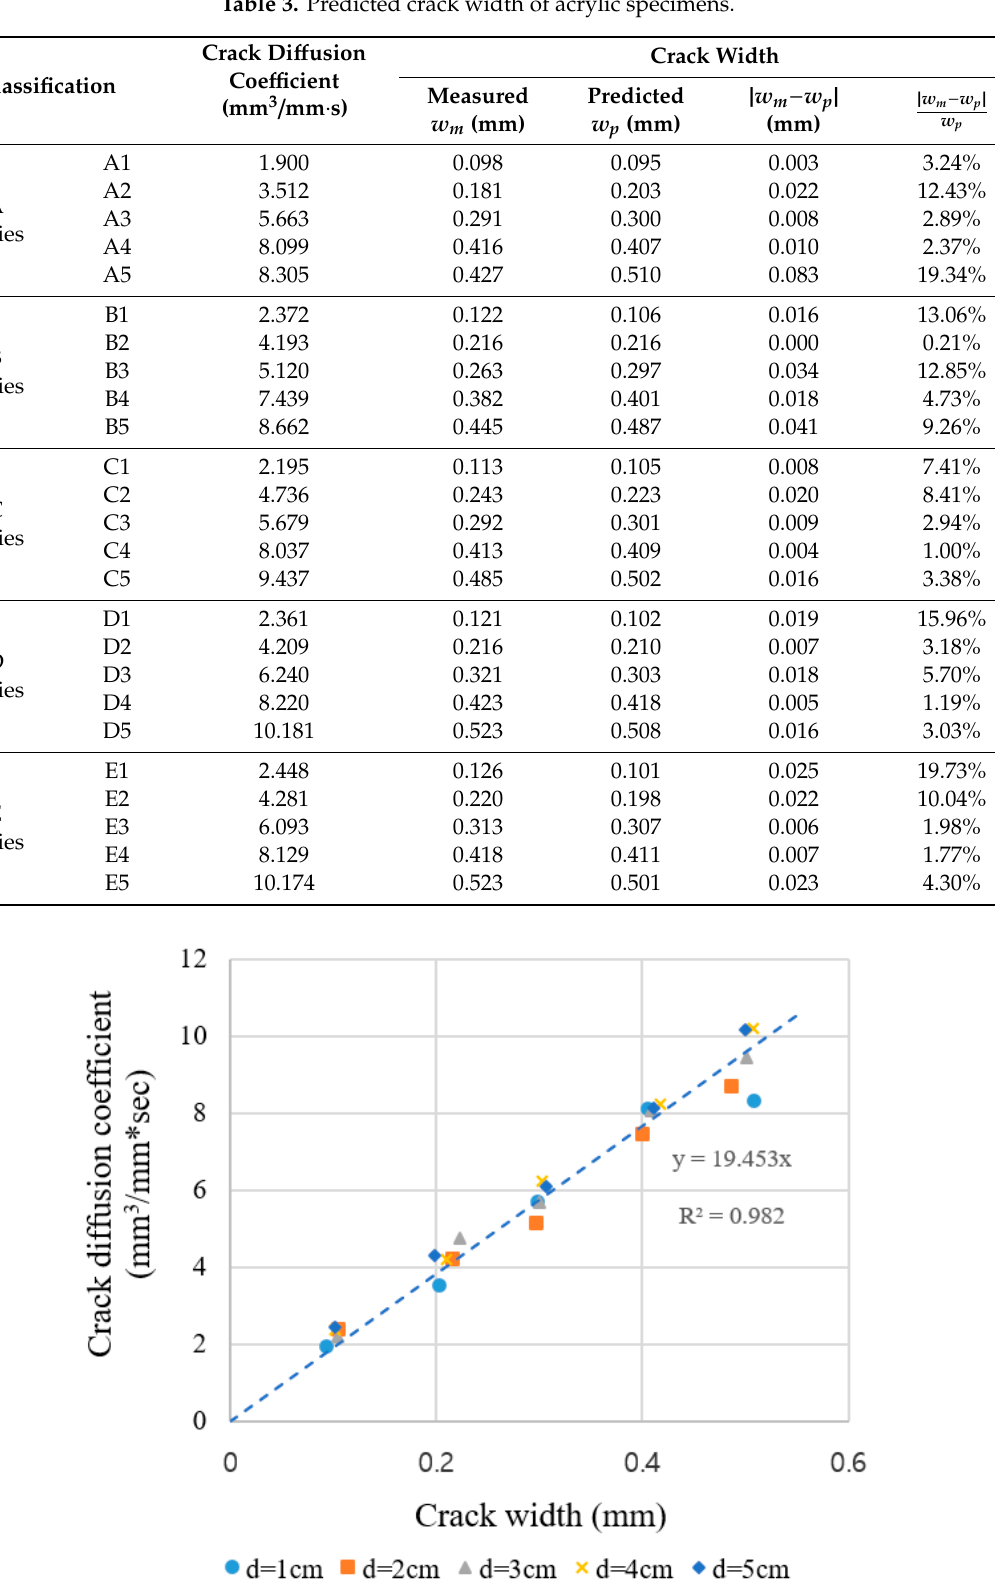
Table 3. Predicted crack width of acrylic specimens.